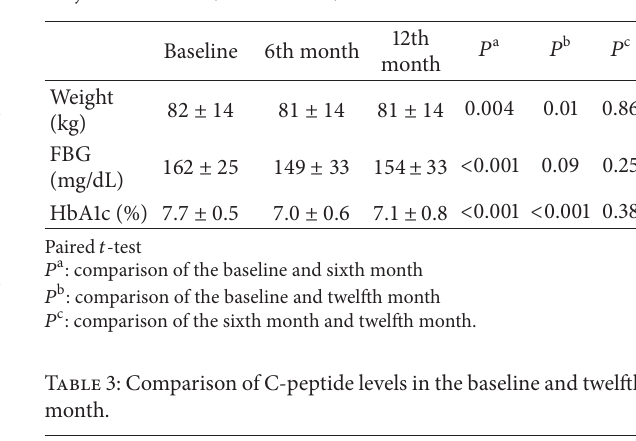
Table 2: Comparison of the weights and glucose parameters in subjects at baseline, sixth month, and twelfth month.